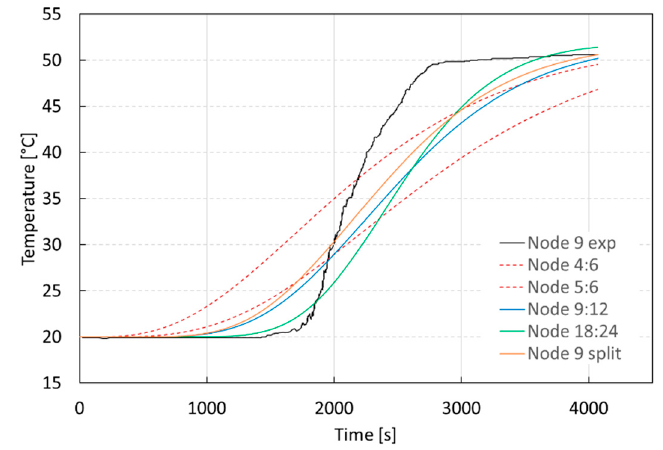
Figure 13. Experimental temperature evolution during the charge phase at node #9 vs. simulation results.